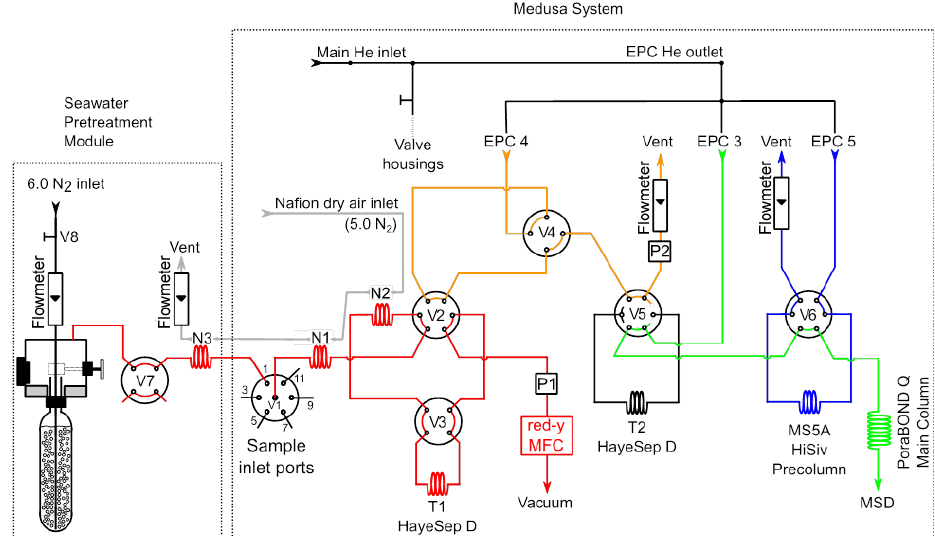
Figure 2. The Medusa–Aqua system flow scheme with the Medusa system identical to Miller et al. (2008). The seawater pretreatment module is added to degas gaseous tracers from samples before injection into Medusa. Electronic pressure controllers (EPC3, EPC4, and EPC5) supply helium throughout the system. The mass flow controller (MFC) is used to measure the sample volume downstream of Trap 1 (T1). The cryogenic packing materials are 200mg of 100 / 120 mesh HayeSep D (HSD) for Trap 1 (T1) and 5.5mg of HSD adsorbent for Trap 2 (T2). N1–N3 are the Nafion driers, and V1–V8 are multiport valves. P1 and P2 are pressure transducers (100PSI-A-DO, All